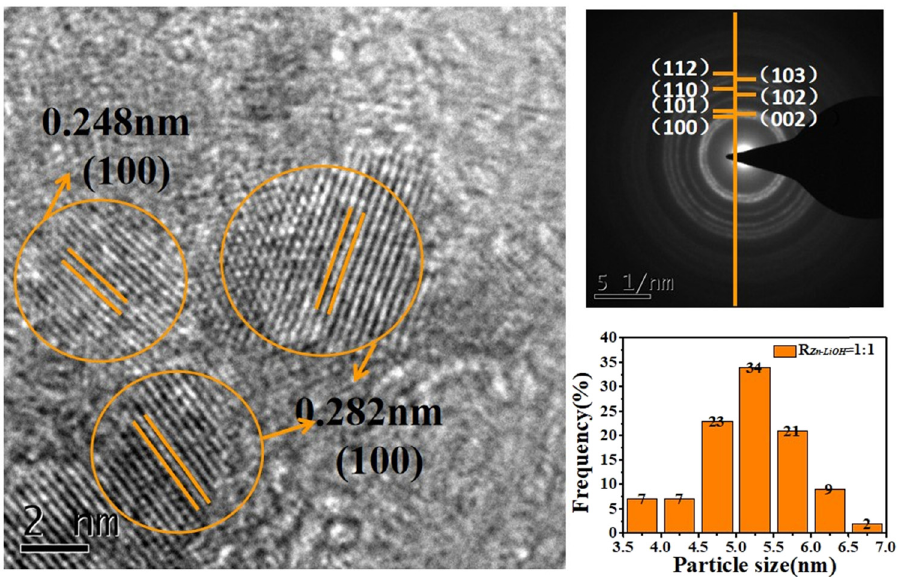
Figure 4: HRTEM image, SAED image, and particle size distribution image of ZnO QDs synthesized at R Zn − LiOH =